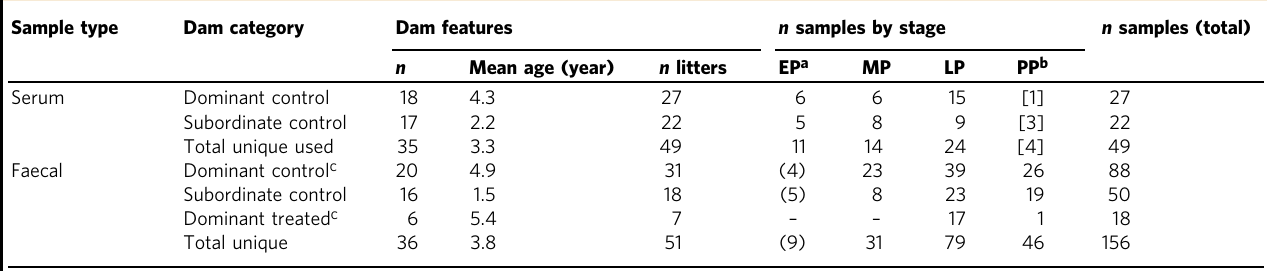
Table 1 Metadata on serum and faecal samples from meerkat dams.